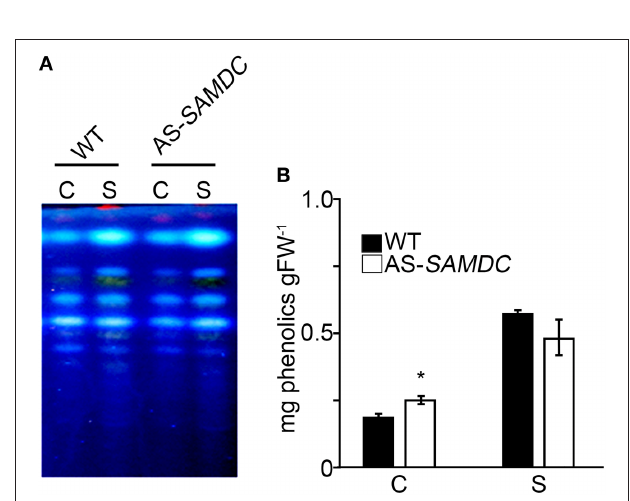
FIGURE 9 | Qualitative and quantitative analysis of total phenolics from WT and AS- SAMDC transgenics. (A) TLC analysis and (B) Quantification of total phenolics from plants 24h post-treatment with 100mM NaCl. Data are means ± SE of three biological replicates. Asterisk indicate significant difference of mean values of AS- SAMDC from WT (Student’s t -test; P <